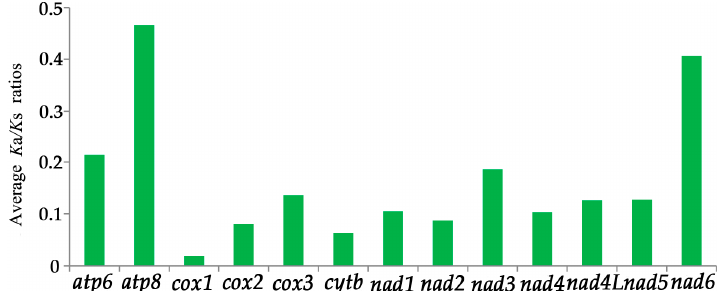
Figure 3. Average K a/ K s ratios of 13 protein-coding genes. K a/ K s is the ratio of non-synonymous substitutions rate ( K a) to synonymous substitutions rate ( K s).